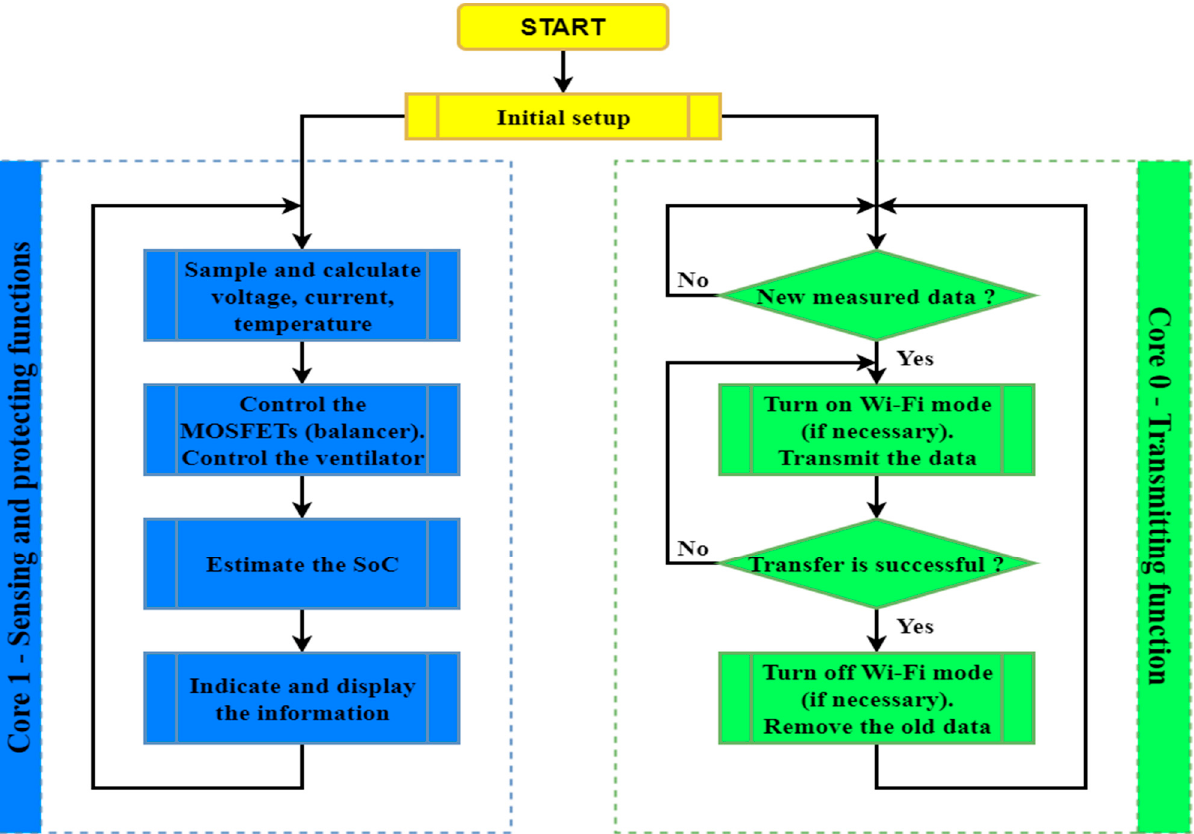
Figure 12. Algorithm flowchart of microcontroller’s firmware.